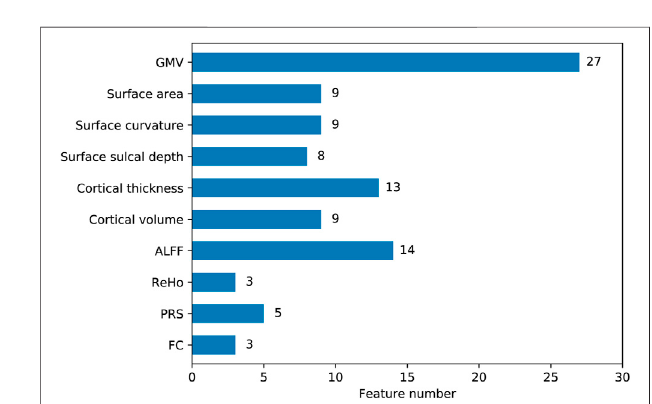
FIGURE 2 | The number of features belonged to each category among thetop100importantfeatures.Theyaxisrepresentedfeaturecategories.The values labeled on the right of the bars were actual feature